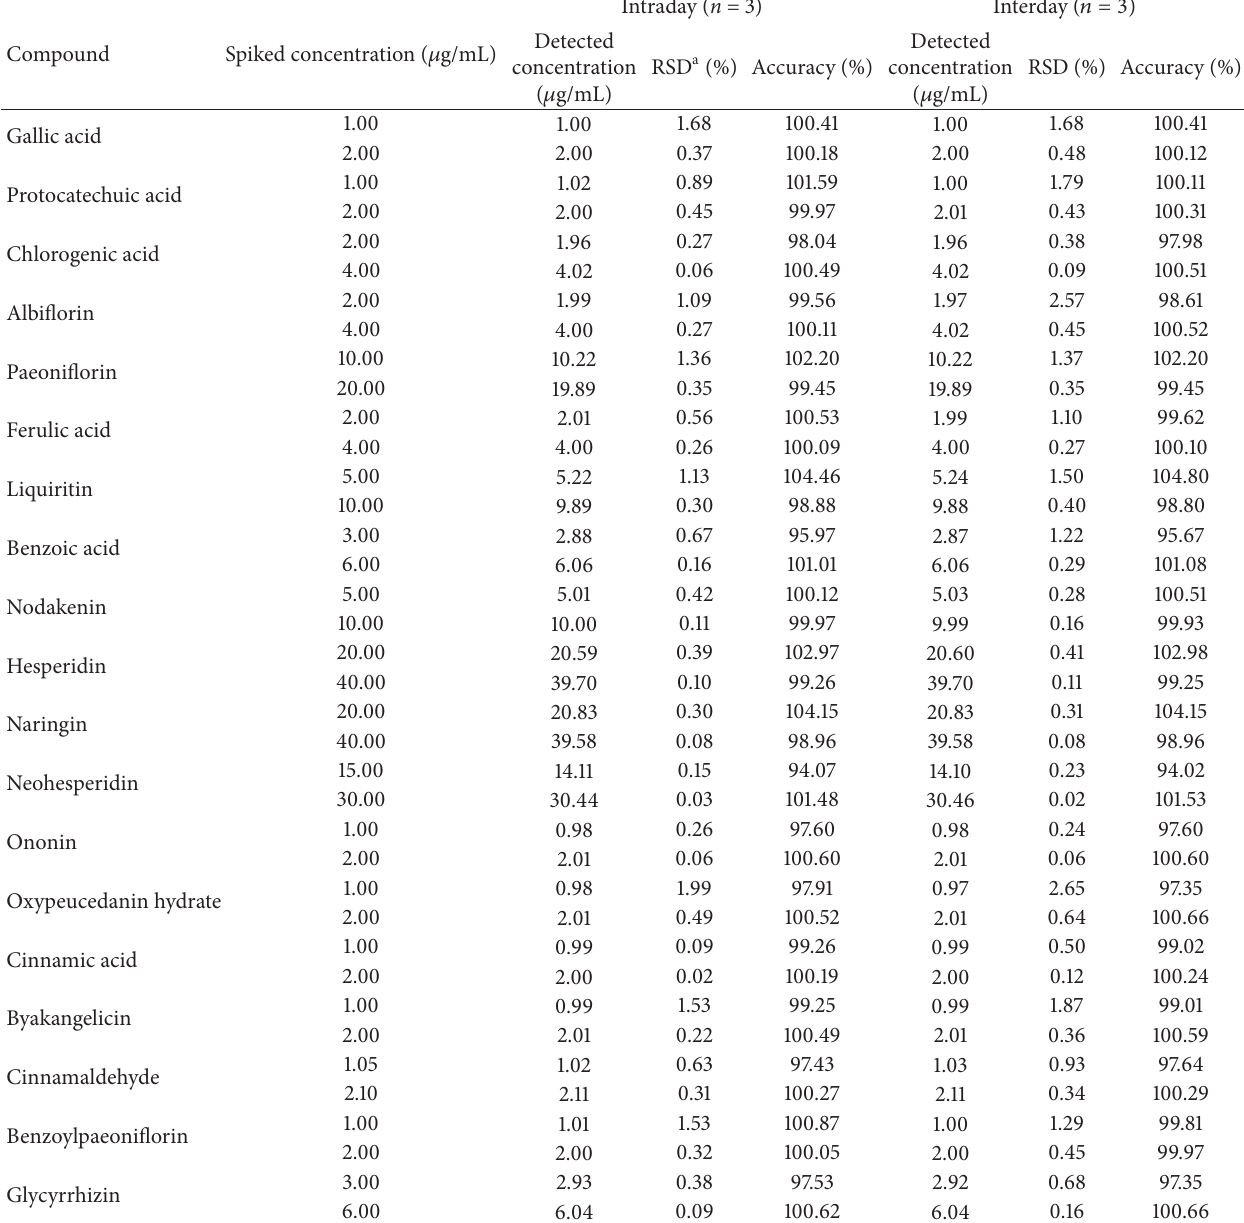
Table 3: Intra- and interday precision of the marker compounds of